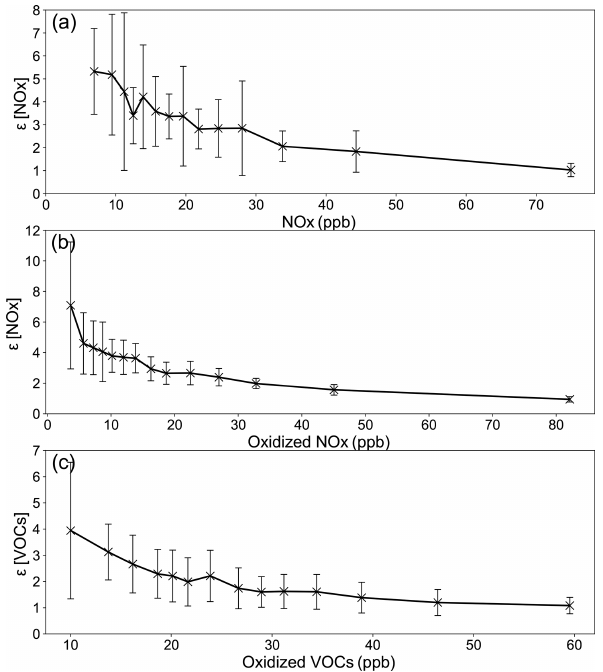
Figure 5. Ozone production efficiency plotted as a function of NO x (a) , oxidized NO x (b) and oxidized VOC (c)